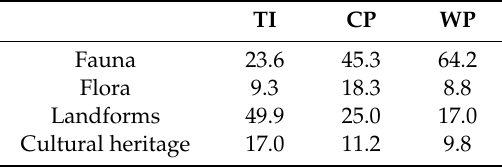
Table 5. First place choices by section (%).